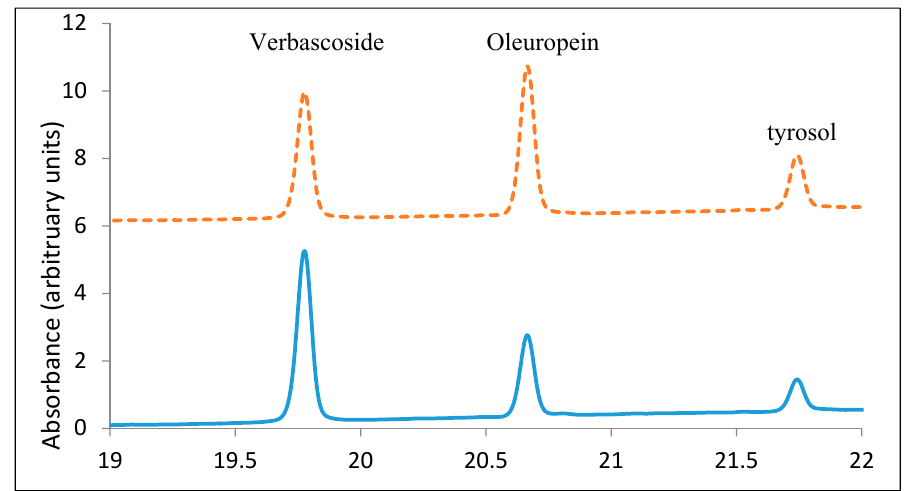
Figure 4. HPLC chromatogram of the olive leaf methanol extracts and the standards.